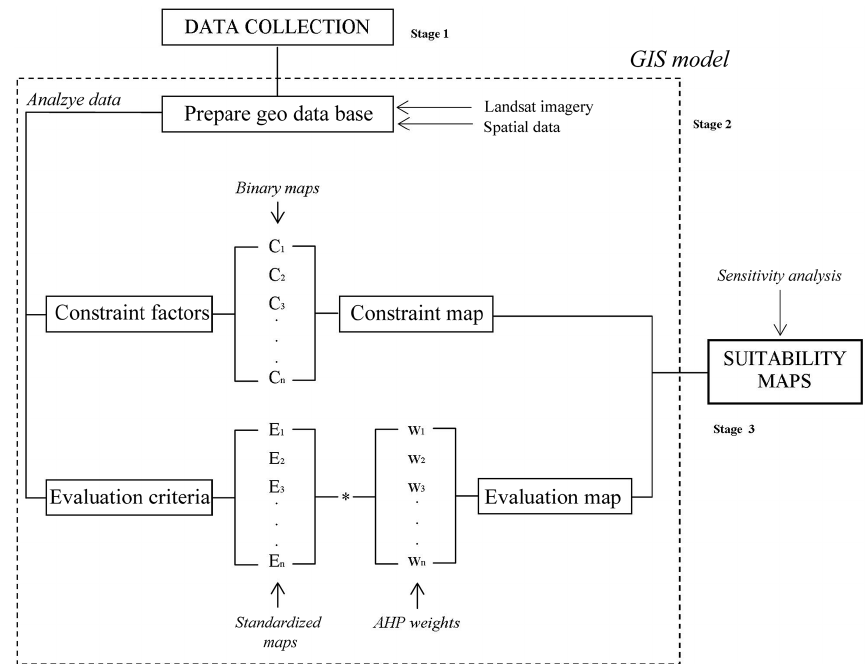
Figure 1. Flow chart of proposed methodology